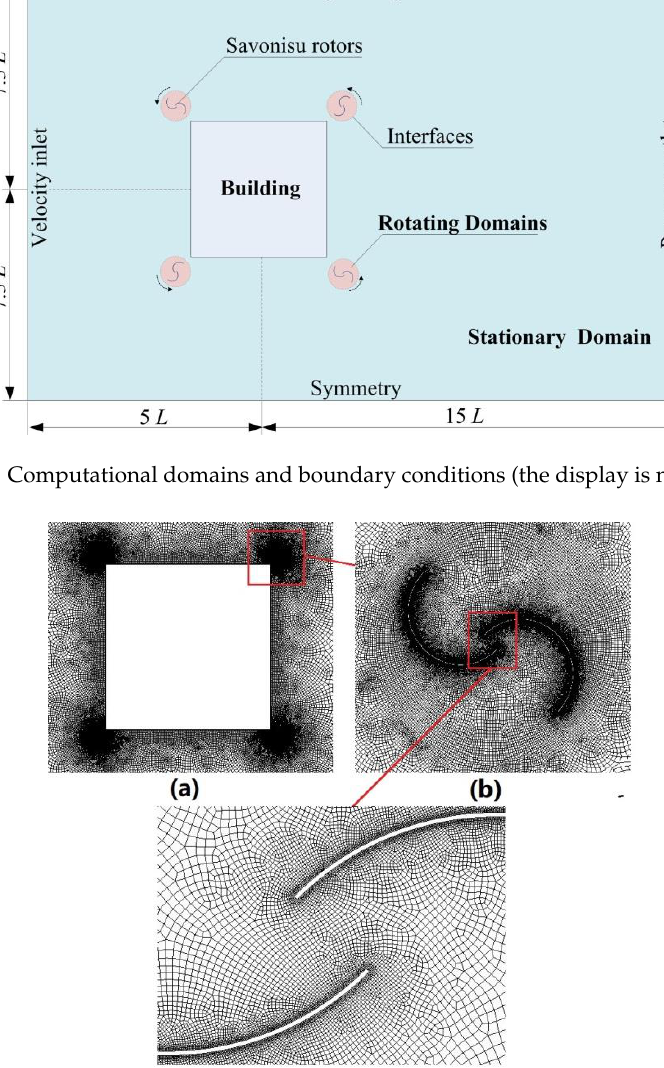
Figure 4. Relative rotation positions around the blades at different rotor angles. ( a ) Domain mesh; ( b ) rotor mesh; ( c ) boundary layer mesh.